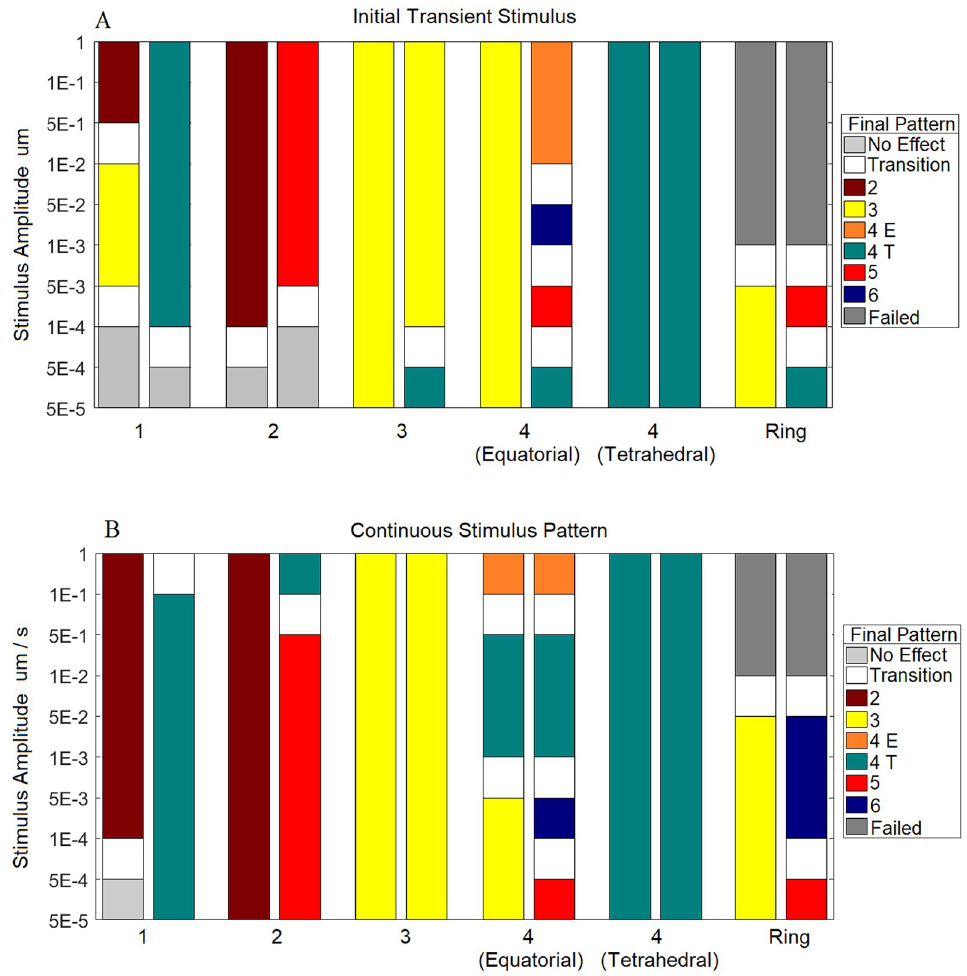
Fig 10. Adding a transient or continuous stimulus to the 3D domain. The type of pattern produced depends on the stimulus pattern, its amplitude, and whether it is transient (A) or continuous (B). Stimuli with larger amplitudes or with three or four spikes were able to better specify the final pattern produced. Left bars show the results for simulations performed on the WT domain; right bars show the results for simulations performed on the larger-size domain. “4 E” represents four spikes on the equator; “4 T” represents four spikes at the corners of a tetrahedron. Some ranges of stimulus amplitudes produced patterns that were not consistently the same; these ranges are marked as “transition”. The ring-patterned transient stimulus caused the PDE solver to fail when the amplitude was too large; these are marked as “Failed”. “No Effect” marks the situations when the produced pattern did not correspond to any positions of the applied stimulus. When a stimulus had an effect on a pattern, we observed at least one of the resulting spikes in all simulations to form at a position where the stimulus was applied. The results in panel A were obtained running Eqs 1 and 2. Panel B was produced using Eqs 2 and